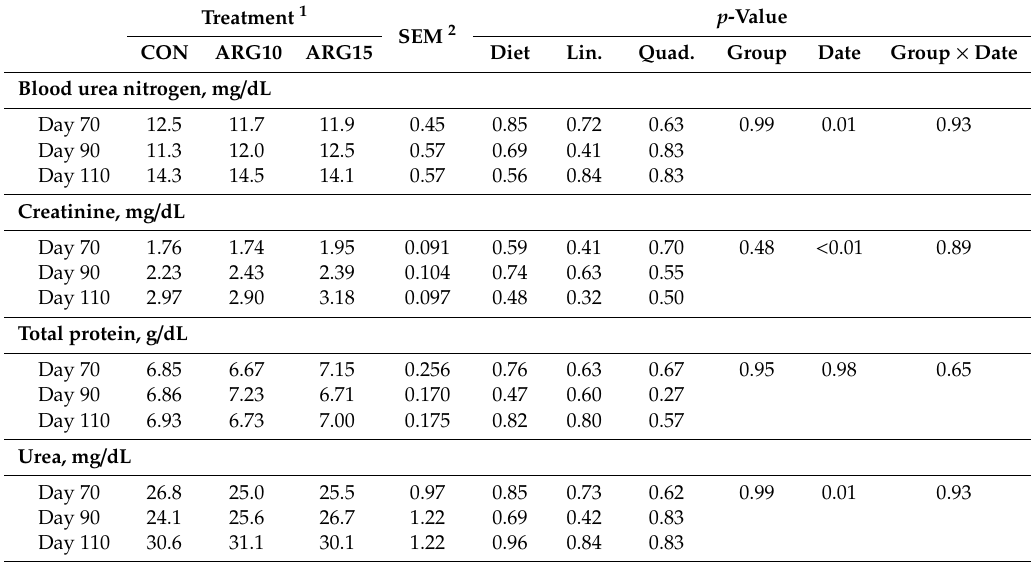
Table 7. E ff ects of arginine supplementation levels on blood profiles in late-gestating